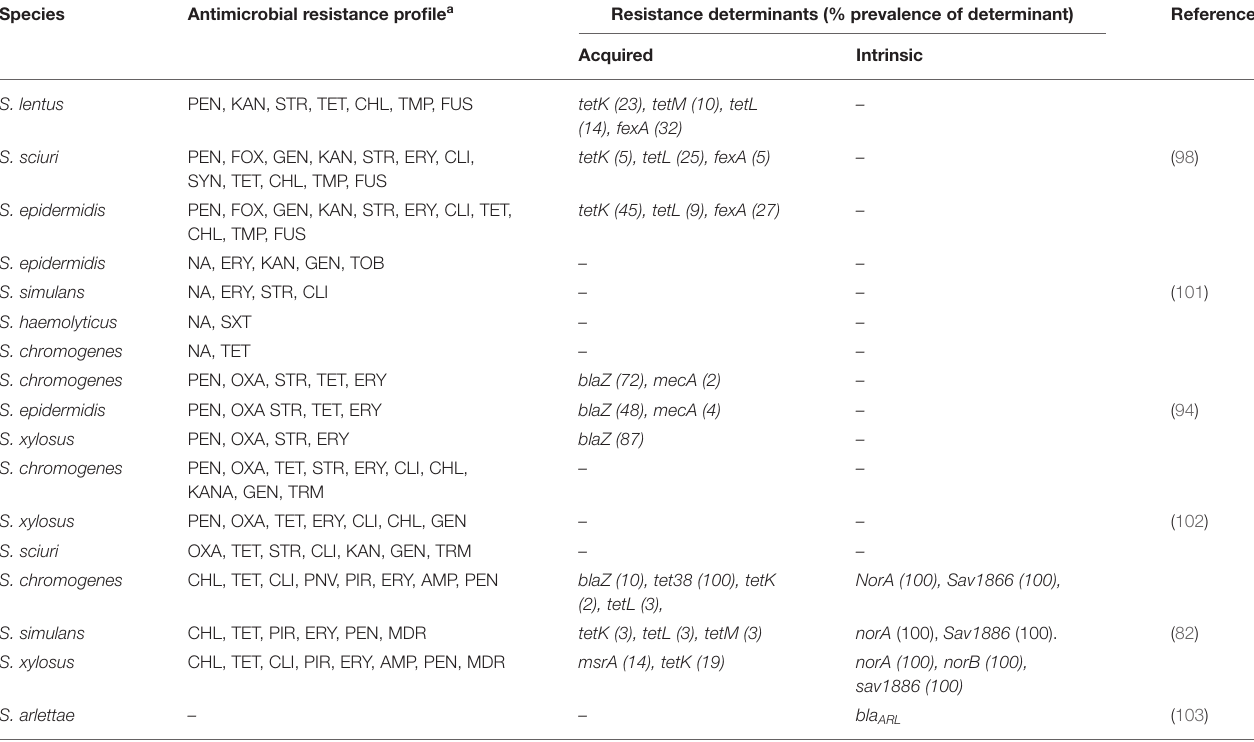
TABLE 4 | Summary of antimicrobial resistance profiles and prevalence of single gene resistance determinants of frequently isolated NAS species across several studies.